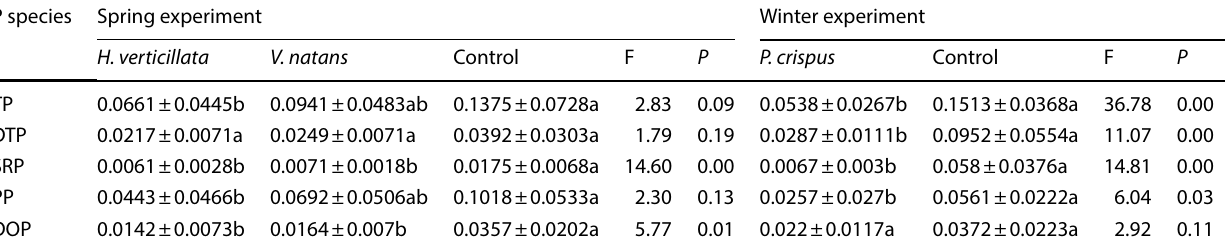
Table 1 One-way ANOVA of P concentrations in overlying water in different treatment groups of the experiment time (mean ± SD, n = 24)